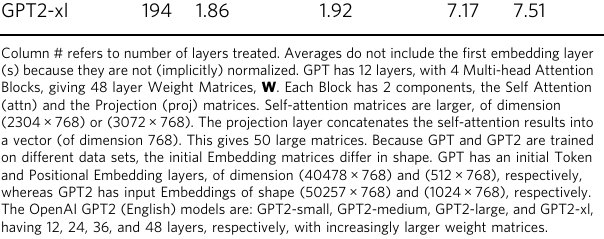
Table 2 Average value for the average Log Norm and Weighted Alpha metrics for pretrained OpenAI GPT and GPT2 models.